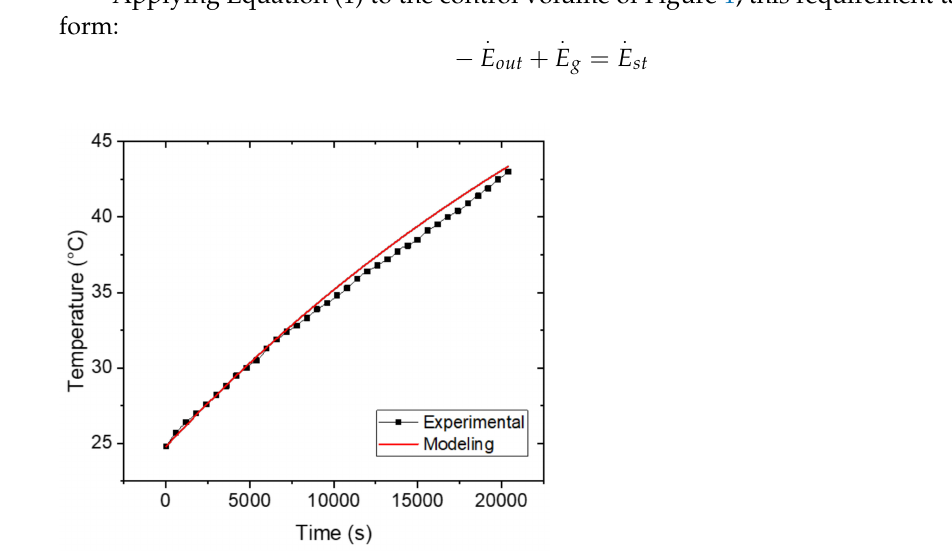
Figure 1. Temporal variation of water temperature obtained with the modeling and